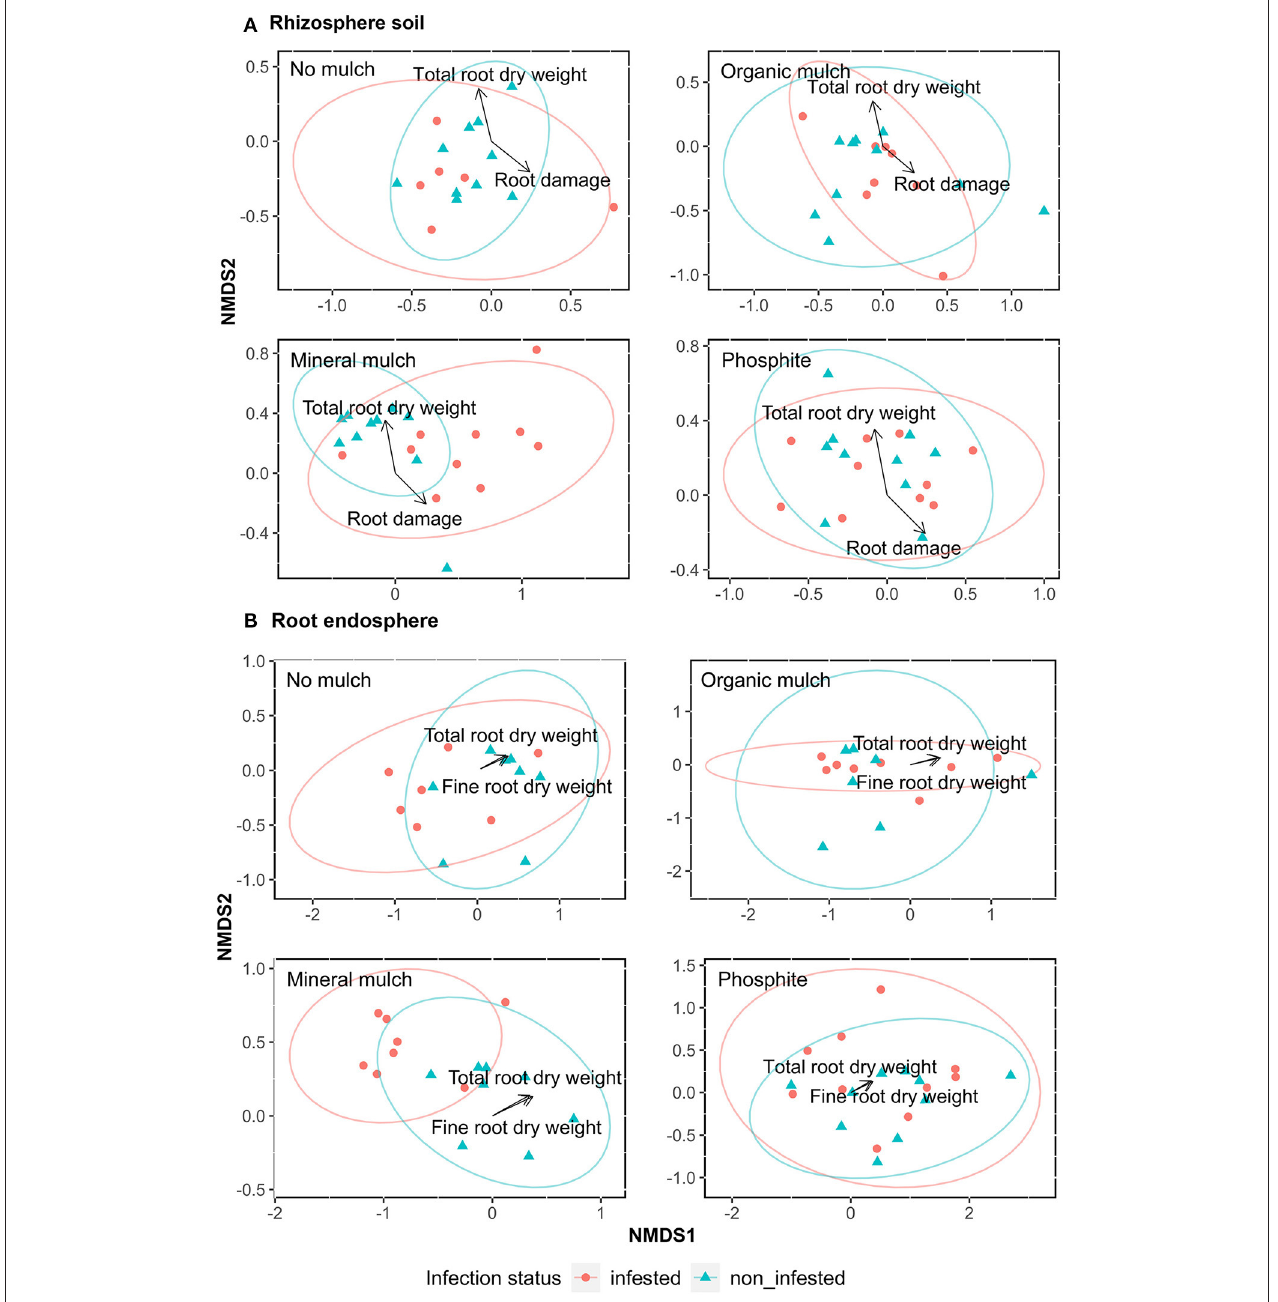
FIGURE 3 | Association of bacterial communities with parameters of root health (total root dry weight, fine root dry weight and root damage) of avocado plants given four soil treatments. Non-metric multidimensional scaling (NMDS) showing the bacterial taxonomic clustering of microbes in (A) rhizosphere soil, and (B) root endosphere from the four treatments. Blue triangles indicate samples from non-infested and red dots treatments infested with P. cinnamomi . The analysis was based on the Bray-Curtis dissimilarity matrix using relative abundance data obtained from a Hellinger-transformation of the number of microbe reads. Data for root health was selected through Adonis PERMANOVA and were from Farooq et al. (2022) Supplementary Table S1 .